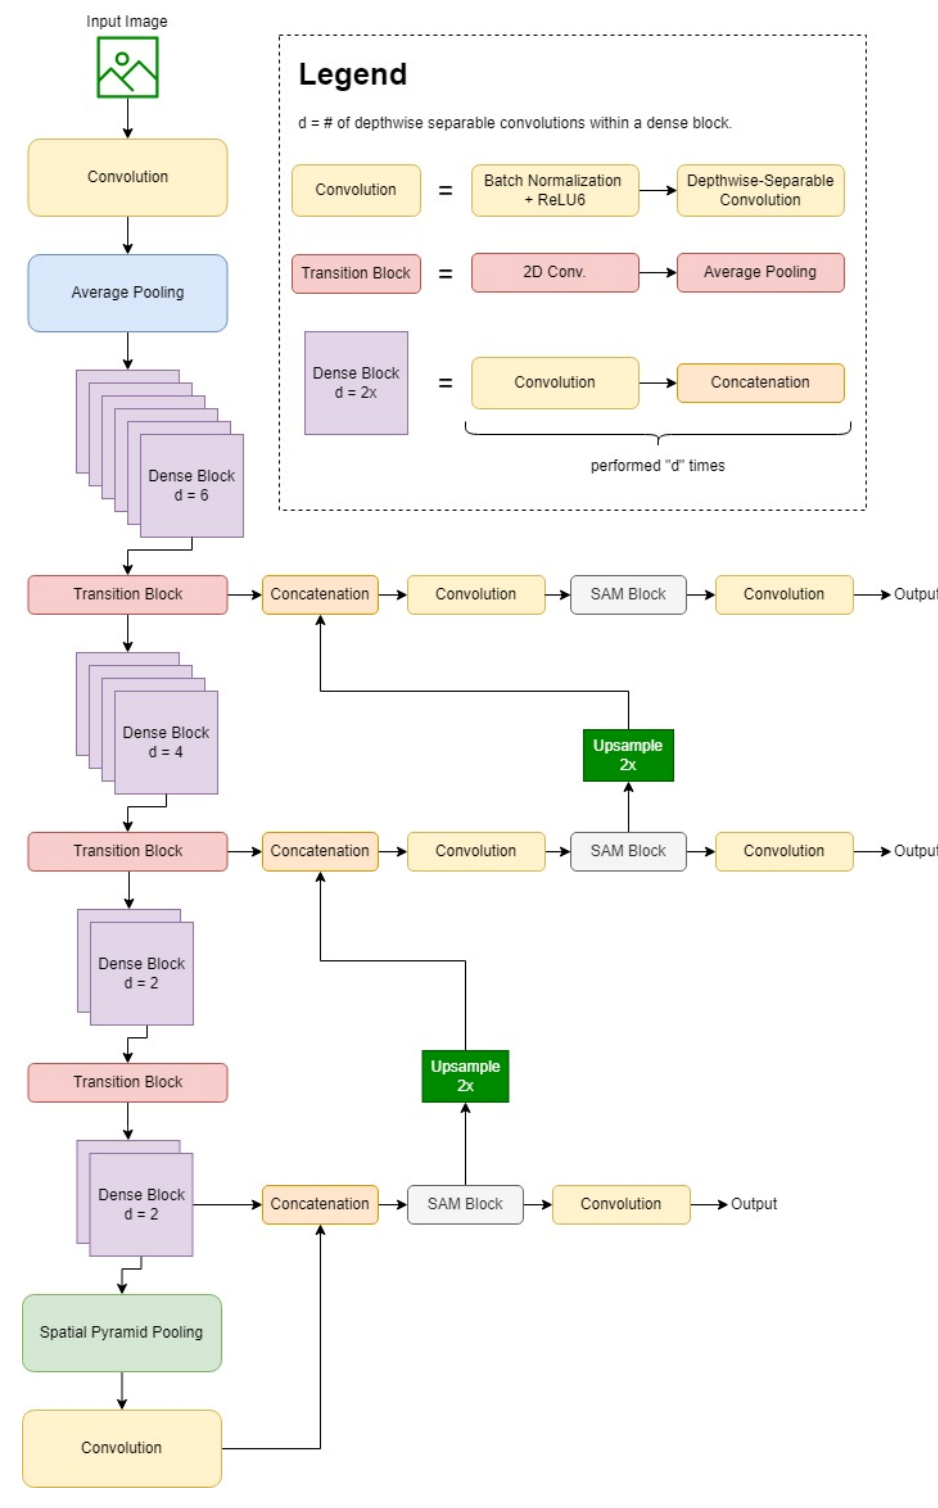
Figure 4. A visual representation of the overall mechanism of the proposed NextDet object detection network. The backbone of this proposed network consists of CondenseNeXt image classifier, the neck consists of Feature Pyramid Network (FPN) with Spatial Pyramid Pooling (SPP) and Path Aggregation Network (PAN) methodologies, and the head consists of an attention block and YOLO pipeline.